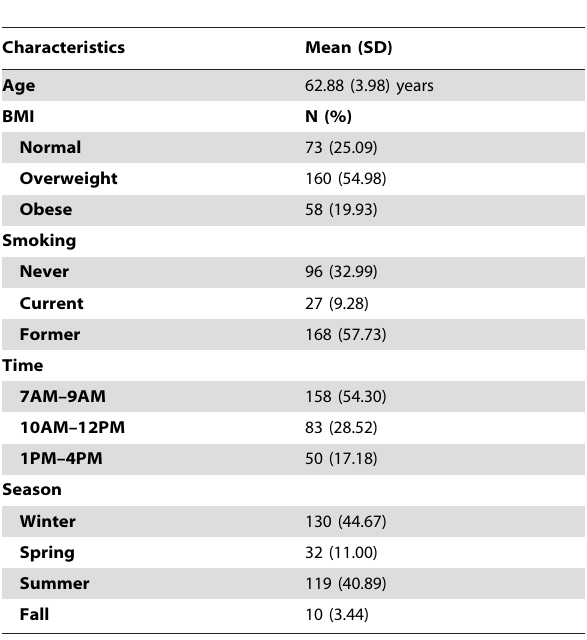
Table 1. Characteristics of the study population.